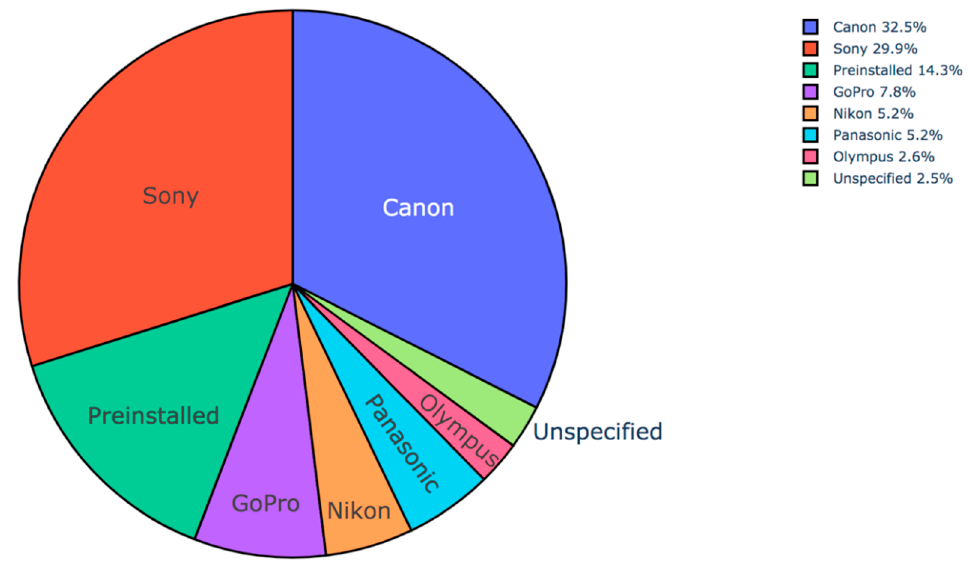
Figure 5. Digital camera brands for RGB collection used by the reviewed studies with percentages representing the proportion of studies utilizing each